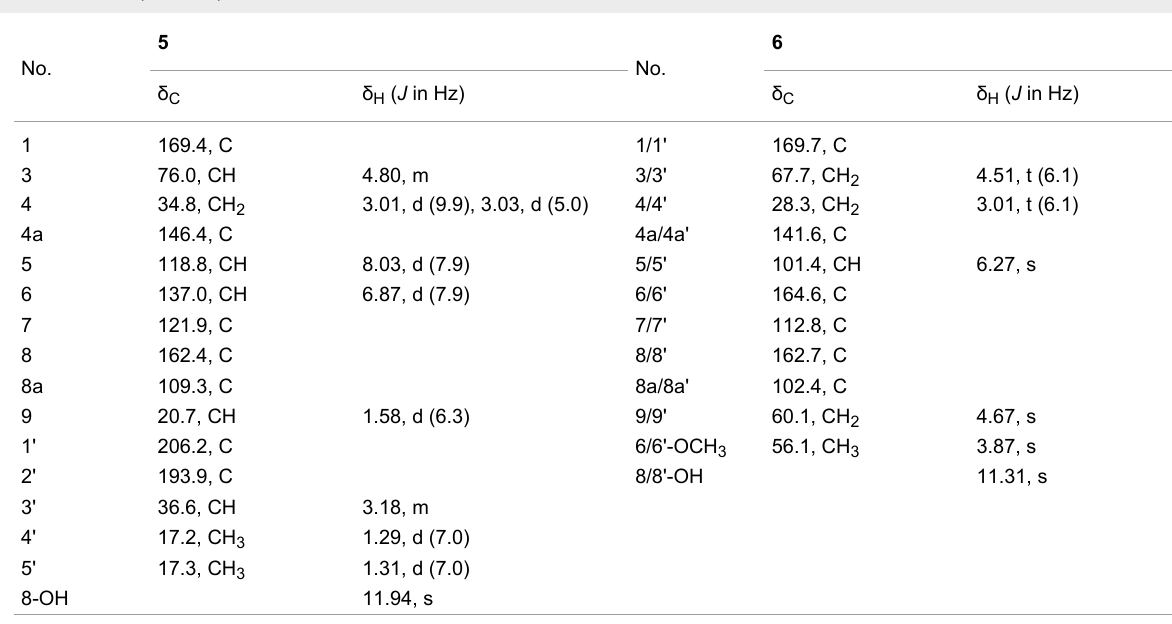
Table 2: NMR Spectroscopic data for 5 and 6 . a